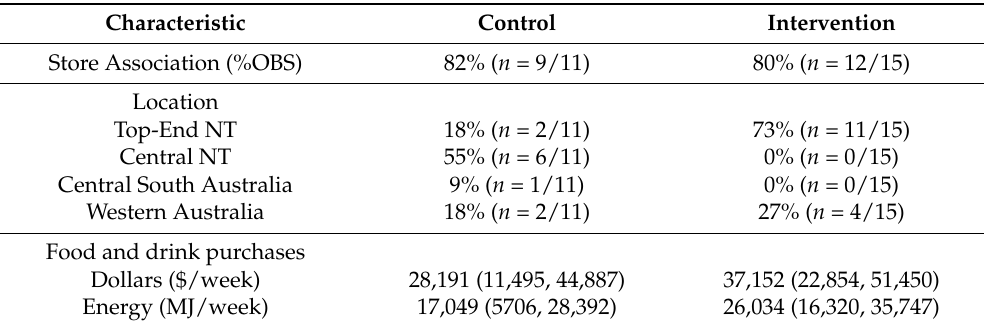
Table 1. Baseline characteristics.